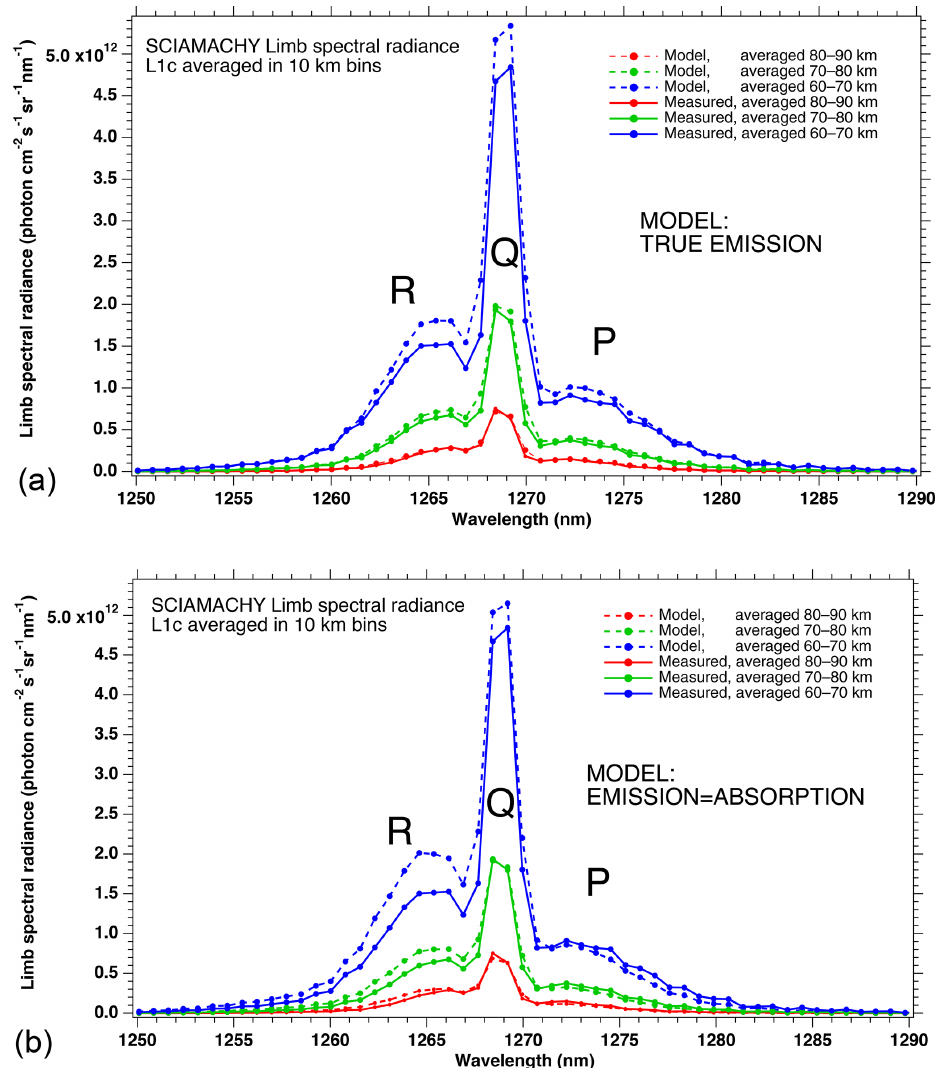
Figure 4. (a) SCIAMACHY limb spectra (solid lines; absolute units are photonscm − 2 s − 1 sr − 1 nm − 1 ), binned by altitudes (60–70, 70–80, and 80–90km), along with our model spectra computed for the same scans and binned in the same way. Panel (b) is the same as (a) but with the crude model in which the shape of the emission of O 2 ∗ is identical to the absorption by O 2 . This crude model shows an excess of emission in the R branch (left) and a deficit in the P